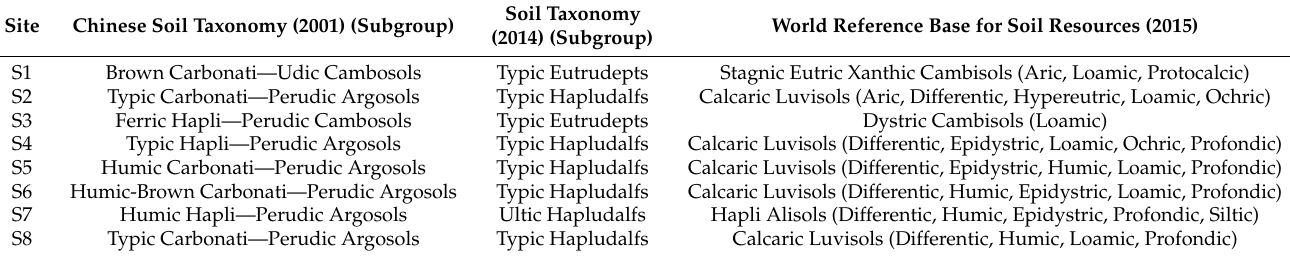
Table 6. The soil classification for soils derived from carbonate rocks along a climosequence in a subtropical mountain, China. Site Chinese Soil Taxonomy (2001) (Subgroup)